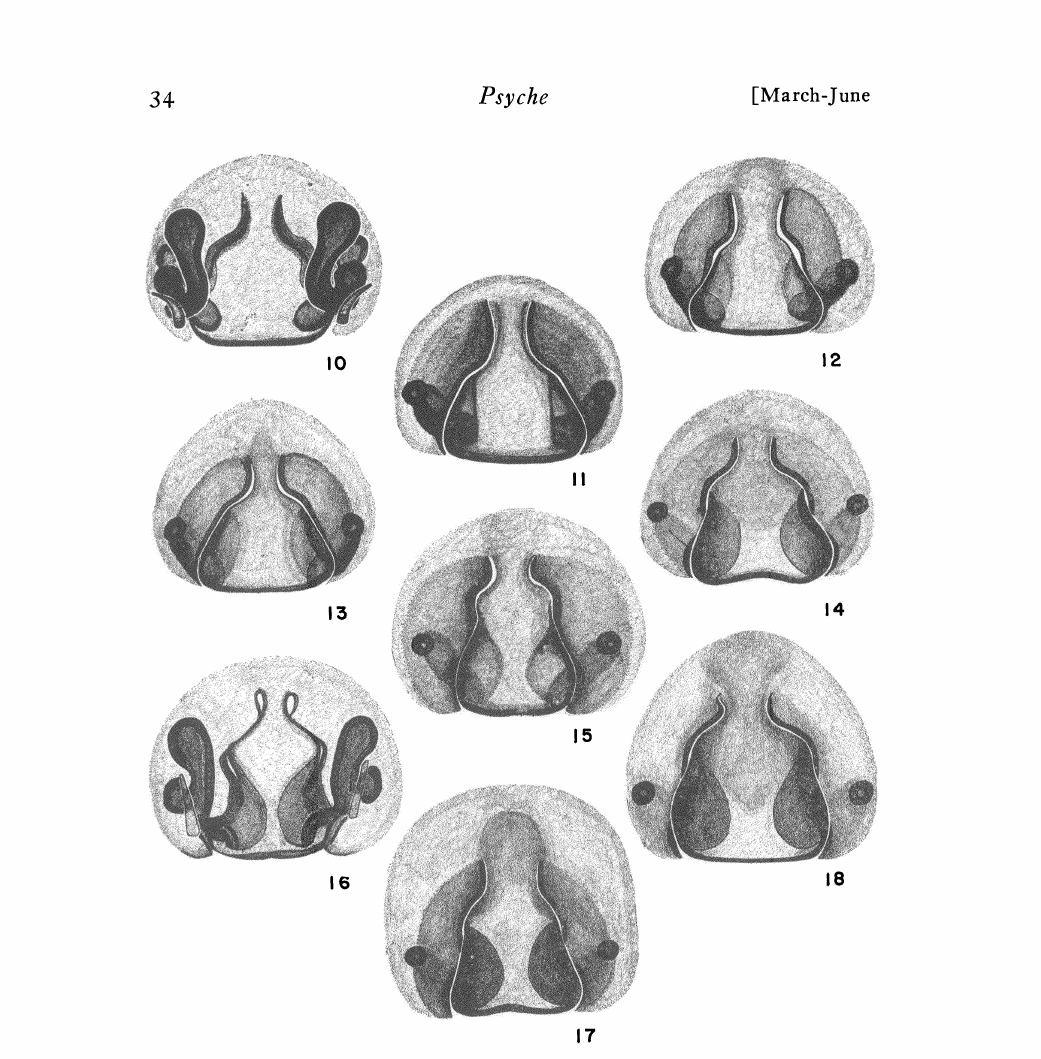
Figs. 10-13. Sosippus floridanus Simon, from Cedar Key, Levy Co., Florida, 9 June 1968. 10. Internal genitalia, dorsal view. 11-13. Epigyna, showing variation. Figs. 14-18. Sosippus janus sp. n., from NW shore of Lake Lochloosa, Alaehua Co., Florida, 11 Apr. and 10 June 1968. 14-15. Epgyna, showing variation. 16. Internal genitalia, dorsal view. 17. Epigynum of female holotype. 18. Epigynum, showing